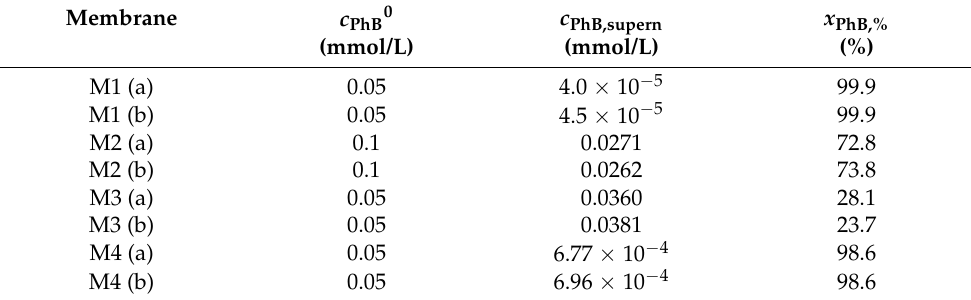
Table 2. The amount of absorbed PhB in the films of organoclays M1–M4. The composition of the samples is explained in Table 1. Two replicate tests were done, assigned as (a) or (b). c PhB0 , c PhB,supern , x PhB,% represent the initial concentrations of PhB, dye concentration determined in supernatants, and mole fraction of absorbed dye in a membrane expressed in %, respectively. x PhB,% was